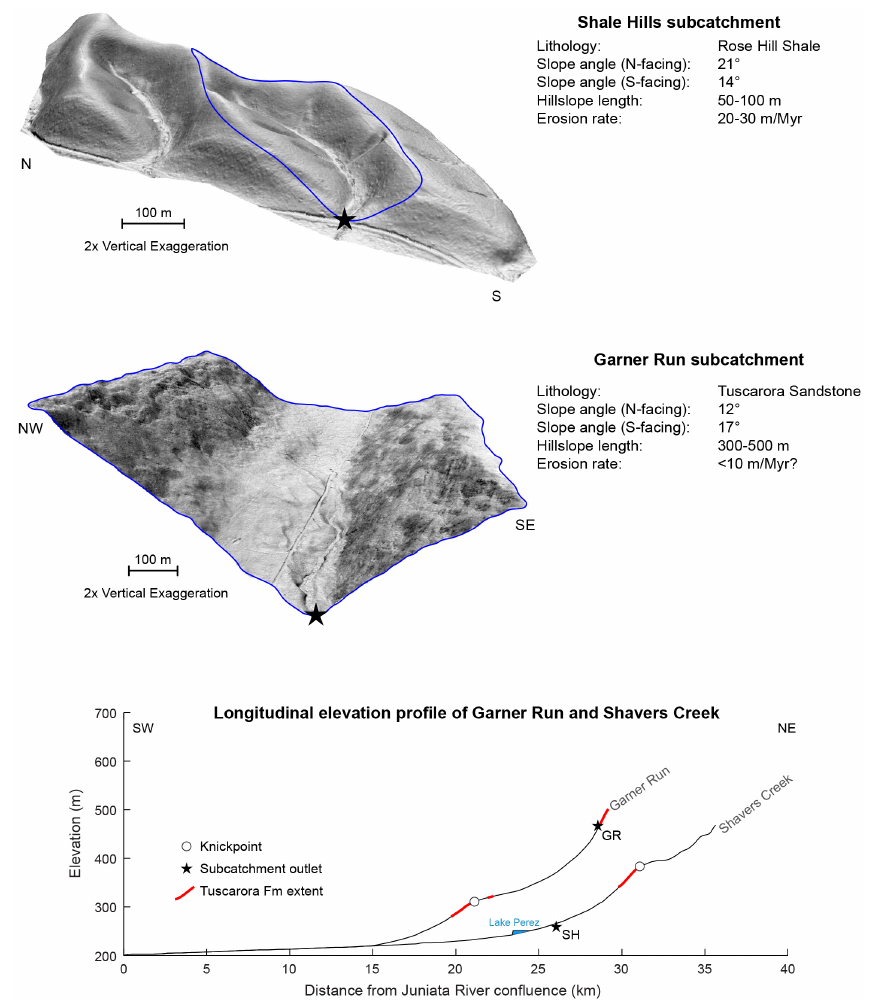
Figure 7. Perspective slopeshade maps (darker shades: steeper slopes) of Shale Hills (top panel) and Garner Run (middle panel) subcatch- ments, emphasizing differences in slope asymmetry and hillslope length. Soil production and erosion rates for Shale Hills subcatchment were measured based on U-series isotopes and meteoric 10 Be concentrations in regolith, respectively (Ma et al., 2013; West et al., 2013, 2014). Erosion rate for Garner Run subcatchment is estimated based on detrital 10 Be concentrations from nearby sandstone catchments with simi- lar relief (Miller et al., 2013). Bottom panel shows stream longitudinal profiles, highlighting the lithologic control on knickpoint locations. Note the location of the Shale Hills subcatchment (SH) downstream of the knickpoint on Shavers Creek and the location of the Garner Run subcatchment (GR) upstream of the knickpoint on Garner